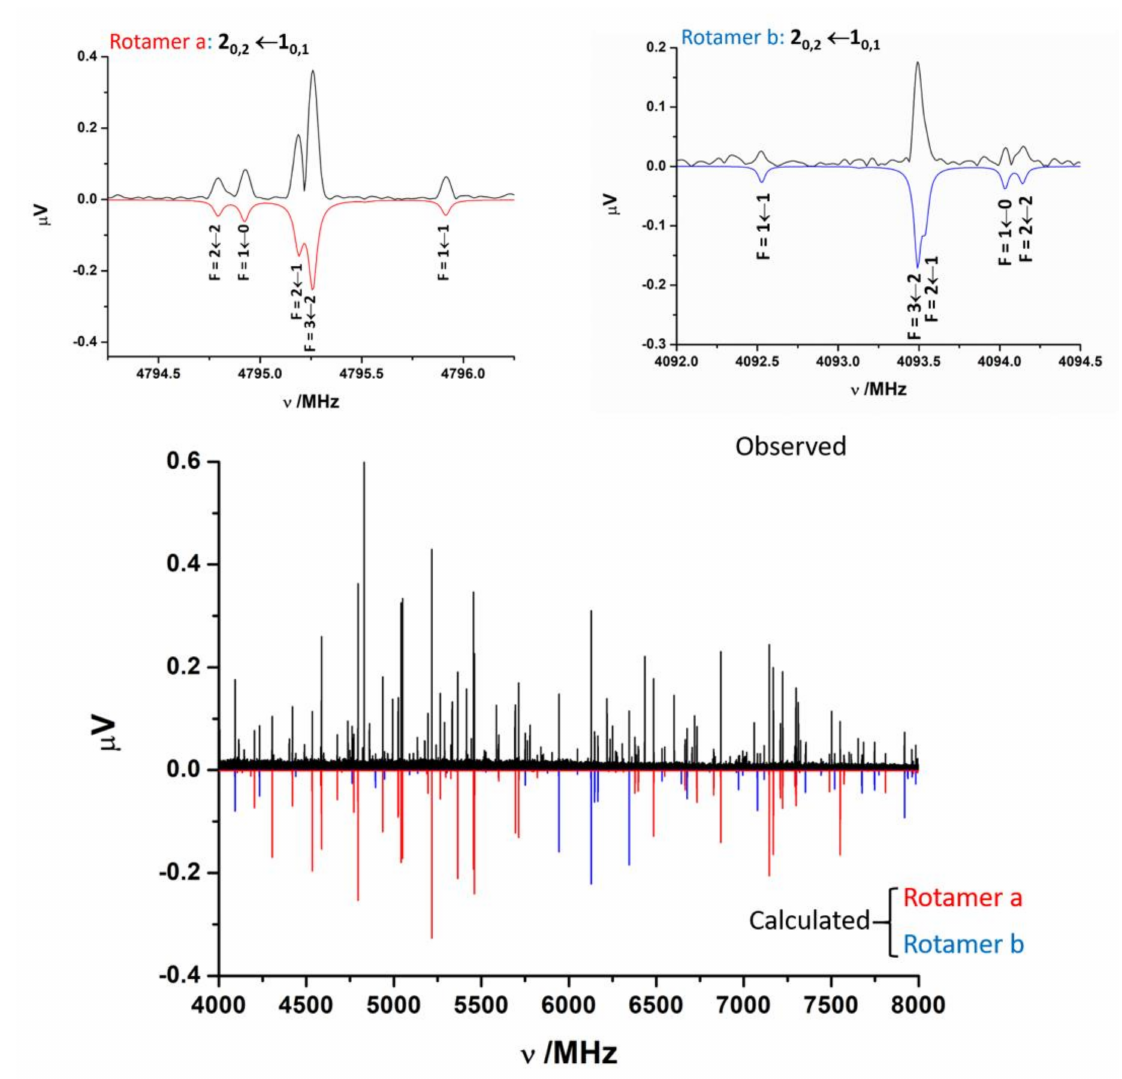
Figure 2. The 4–8 GHz CP-FTMW spectrum of laser-ablated SPro is shown. Two rotamers a and b of thioproline have been identified. The spectra calculated from the experimentally determined rotational parameters are shown below, in red for rotamer a and in blue for rotamer b . The figure shows also in detail the hyperfine F (cid:48) ← F” components associated to the 2 0,2 ← 1 0,1 transition for both rotamers. Besides the rotational parameters the 14 N hyperfine structure, markedly different for these rotamers, is a key for the identification of the different